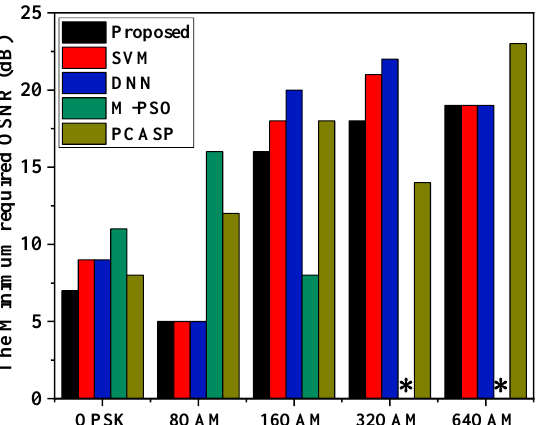
Figure 11. Minimum required OSNR for identifying different modulation formats for five MFI schemes. * indicates the modulation format is not identified by this scheme.